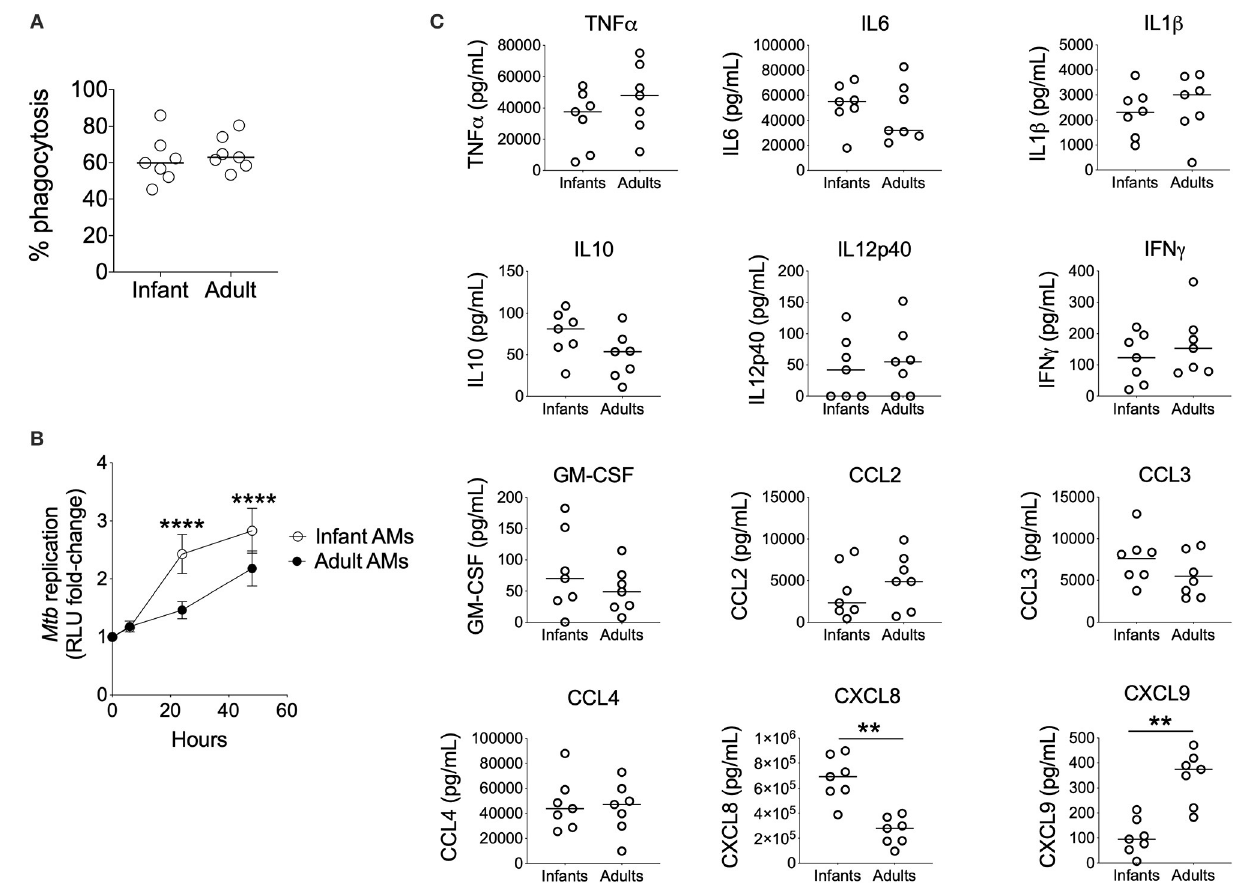
FIGURE 2 | Impaired control of Mtb by Infant AM φ s. (A) Phagocytosis of Mtb-LuxG13 by AM φ s from seven infants and seven adults after 2h of incubation at MOI 5:1. Proportion of phagocytosed bacteria assessed by measurement of autoluminescence after removal of extracellular bacilli with PBS washes, as a percentage of autoluminescence before PBS washes. Each data point represents a single observation from a single participant. Bar denotes median; (B) Ability of AM φ s to restrict replication of Mtb-LuxG13. Data points represent mean (bar = SD) of AM φ s from seven infants (empty circles) compared with seven adults (filled circles), and line shows fold-change in autoluminescence calculated from serial measurements relative to zero time point, following 2h of incubation with Mtb-LuxG13 at MOI 5:1. Significance determined by 2-way ANOVA and denoted by ****( p < 0.0001); (C) Soluble inflammatory mediator production in culture supernatants by infant vs. adult AM φ s at 24h post infection with Mtb-LuxG13. Significance determined by Mann-Whitney test. Statistically significant results denoted by **( q < 0.01) and after correction for multiple comparisons by Benjamini-Hochberg